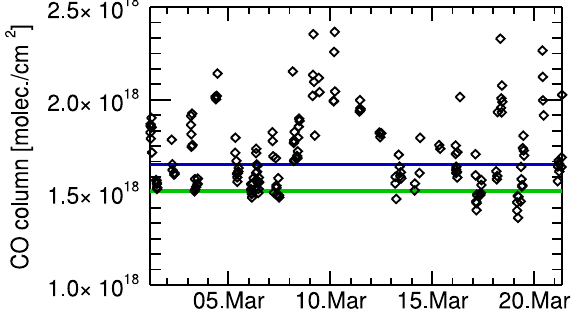
Fig. 1. CO column measurements at the edge of the MCMA. The observed variability can be explained reasonably well by the wind pattern classification of de Foy et al. (2008) (see text). The columns consist of the background value plus an additional part of fresh CO depending on the wind direction and strength. As columns cannot be negative we assume a log-normal distribution. The two horizon- tal lines represent the median value (blue) and the green, µ ∗ /σ ∗ , calculated from the average of the natural logarithm of the columns separating an interval of the lowest 15.85% in a log-normal dis- tribution ( µ ∗ = Exp ( avgr .( ln (x))) , σ ∗ = Exp ( stdev .( ln (x)))) . This lower limit (green) lies at 1 . 51 × 10 18 moleccm − 2 and is used to define the border of the MCMA CO-footprint.